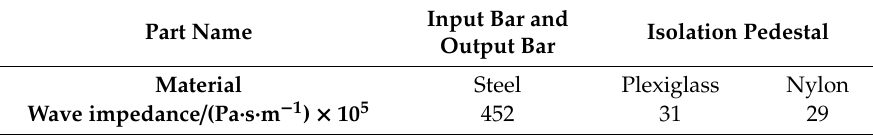
Figure 7. Experiment of stress wave isolation: ( a ) local structure diagram of the experiment; ( b ) the isolation pedestal dimensions (all dimensions in mm); ( c ) photograph of the isolation pedestals. Table 2. Wave impedance parameters of each material in the